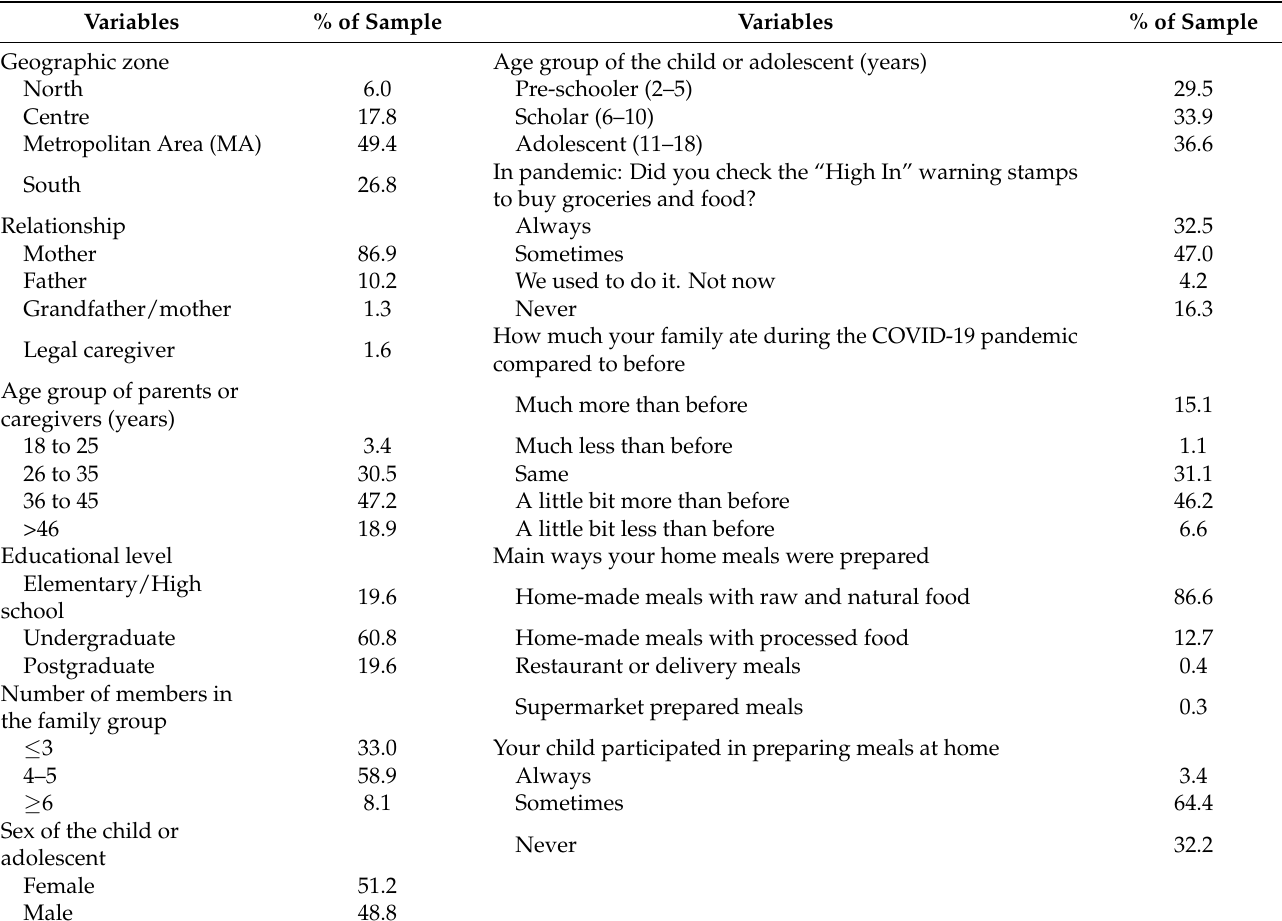
Table 1. Sociodemographic and nutritional characteristics of the study groups.